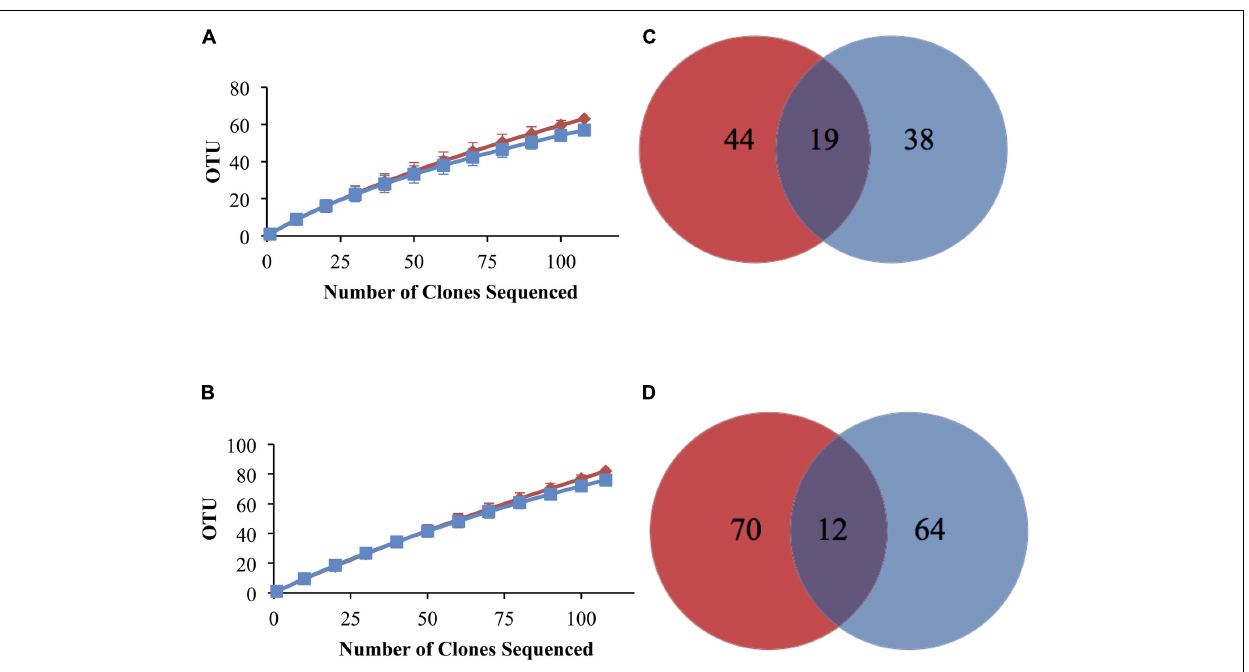
FIGURE 2 | Rarefaction analysis of bacterial 16S rRNA gene clone sequence data andVenn diagrams showing distribution of total and shared OTUs at 7% (A,C) and 3% (B,D) distance cutoff in lignocellulose-responsive (blue) and non-responsive (red) bacterial communities. Error bars are 95% confidence